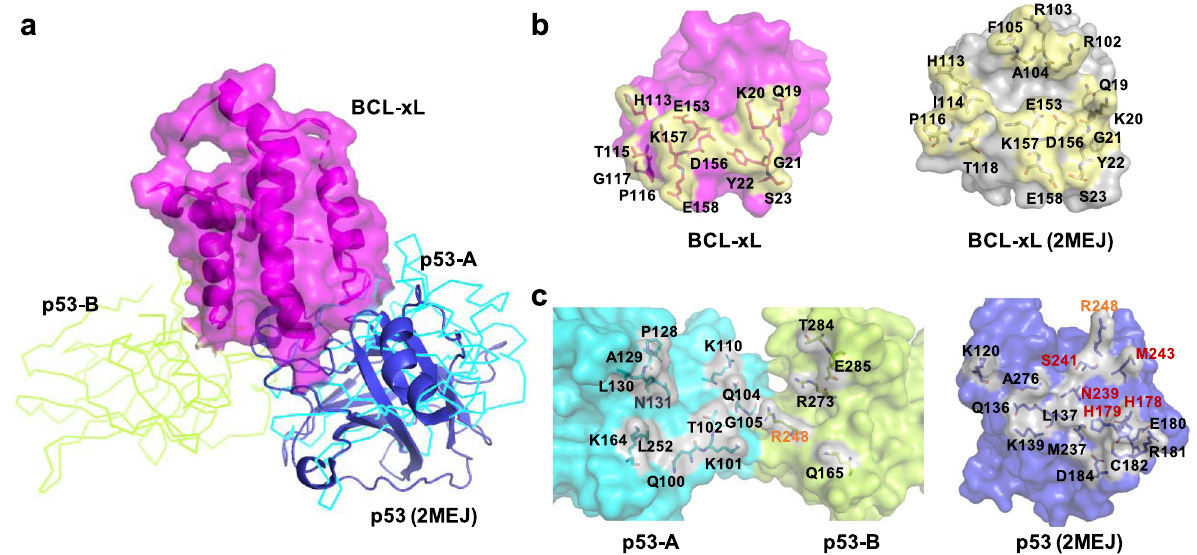
Fig. 3 Comparison with previously proposed structural model. a Our BCL-xL/p53 structure is superimposed on the previous structural model (PDB: 2MEJ) using BCL-xL-C as the reference. A surface model of BCL-xL is shown in magenta, p53-A is shown as cyan ribbon, p53-B is shown as limon ribbon, the p53 molecule from the previous model is shown as blue cartoon. b A detailed comparison of the interaction surfaces on BCL-xL. The BCL-xL in our structure is shown as magenta surface. The BCL-xL in the previous structural model is shown as gray surface. The interface is shown in yellow, with all the interaction residues labeled. c . A detailed comparison of the interaction surfaces on p53-DBD. The p53-DBD dimer in our structure is shown as cyan and limon surface. The p53-DBD in the previous model is shown as blue surface. The interface is shown in gray, with all the interaction residues labeled. Arg248 (labeled in orange) interacts with BCL-xL in both structures. Residues labeled in red are projected to bind BCL-xL in the previous model, while they are involved in p53-DBD dimerization in our structure.